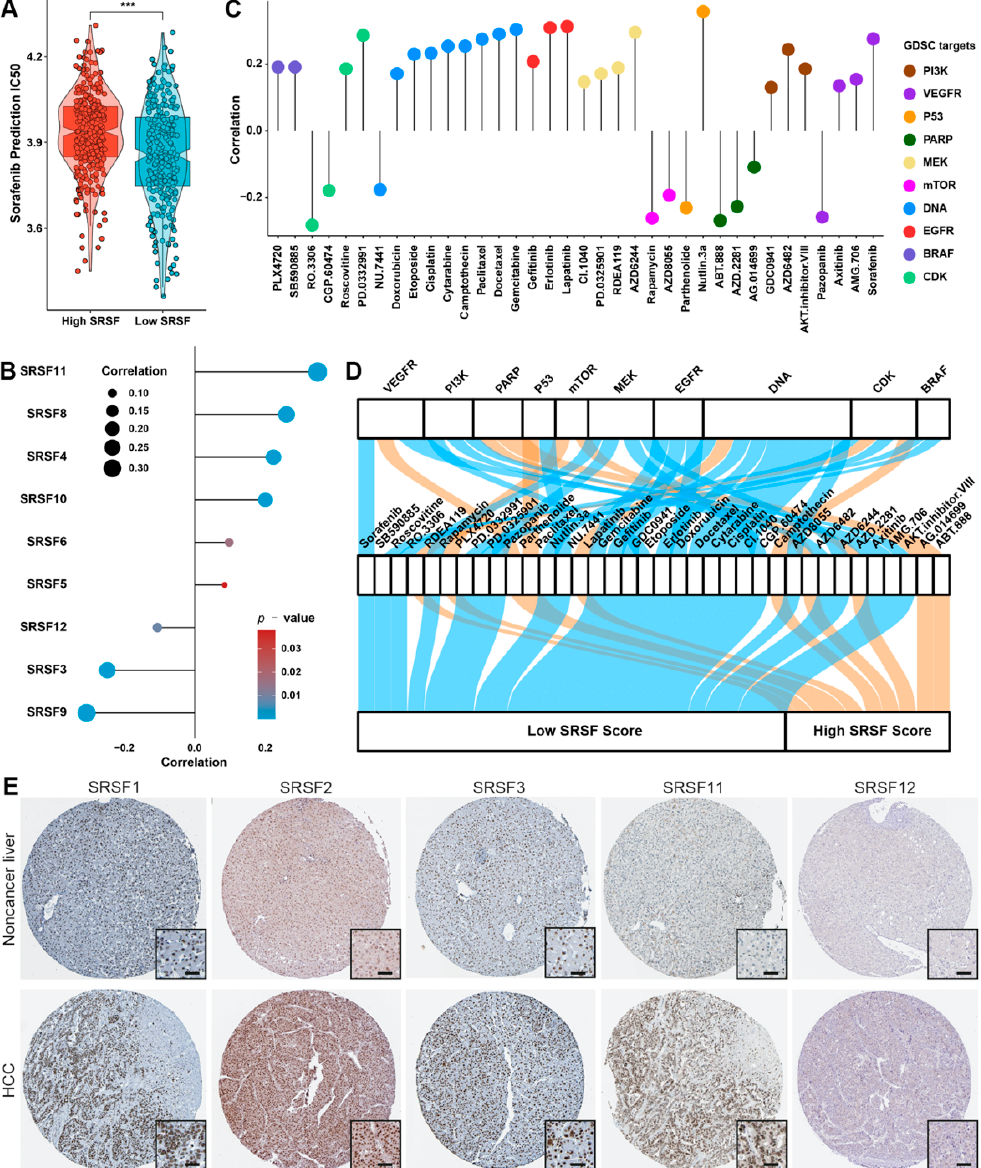
Figure 7. Evaluation of SRSF score for drug sensitivity analysis in HCC patients. ( A ) Predicted IC50 of sorafenib according to the GDSC database. The asterisks represent the statistical p -value (*** p < 0.001). ( B ) Correlation analysis between SRSF family genes and predicted IC50 of sorafenib from the GDSC database. ( C ) Correlation analysis between SRSF scores and predicted IC50 values for the indicated inhibitors from the GDSC database. ( D ) Alluvial plot showing the changes in drug targets, drug titles and SRSF scores. ( E ) Representative IHC images of SRSF family members in HCC and nontumor liver tissue from the Human Protein Atlas. Scale bar denotes 50 µ